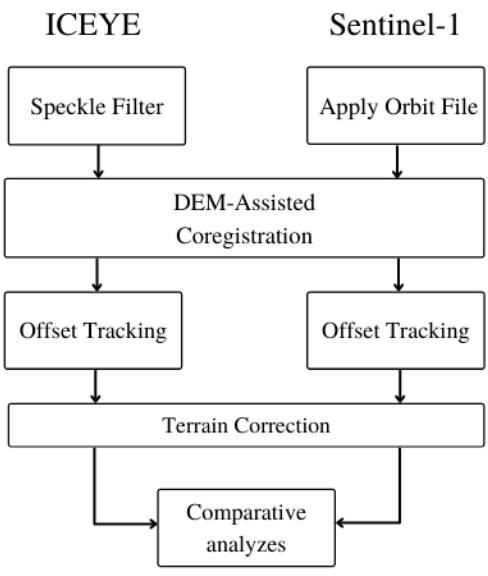
Figure 2. Data processing for ICEYE and Sentinel-1 missions. Table 2. Parameters selected for calculations using the offset-tracking